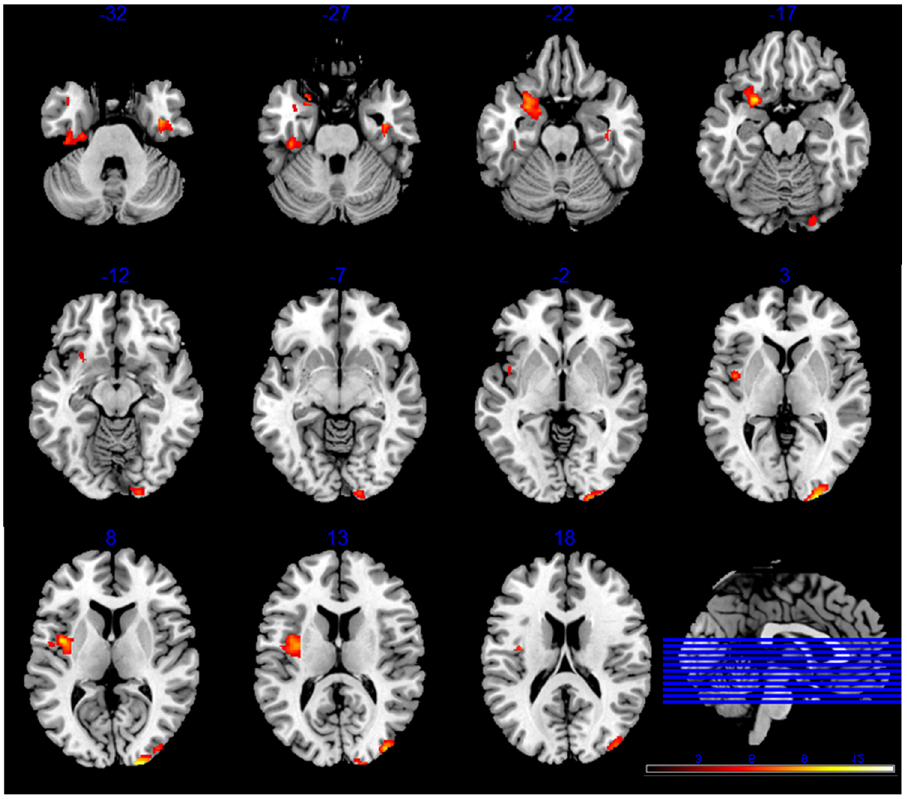
Fig. 1 One-way ANOVA analysis shows differences in GMV across the four groups (CN, UFDR, UHR, and FES). The statistical map was thresholder at P voxel-wise < 0.005 (uncorrected), then corrected for multiple comparisons to P FWE < 0.05 by using a cluster threshold ( k > 691 voxels or 2332.125 mm 3 ). Color bars represent the F